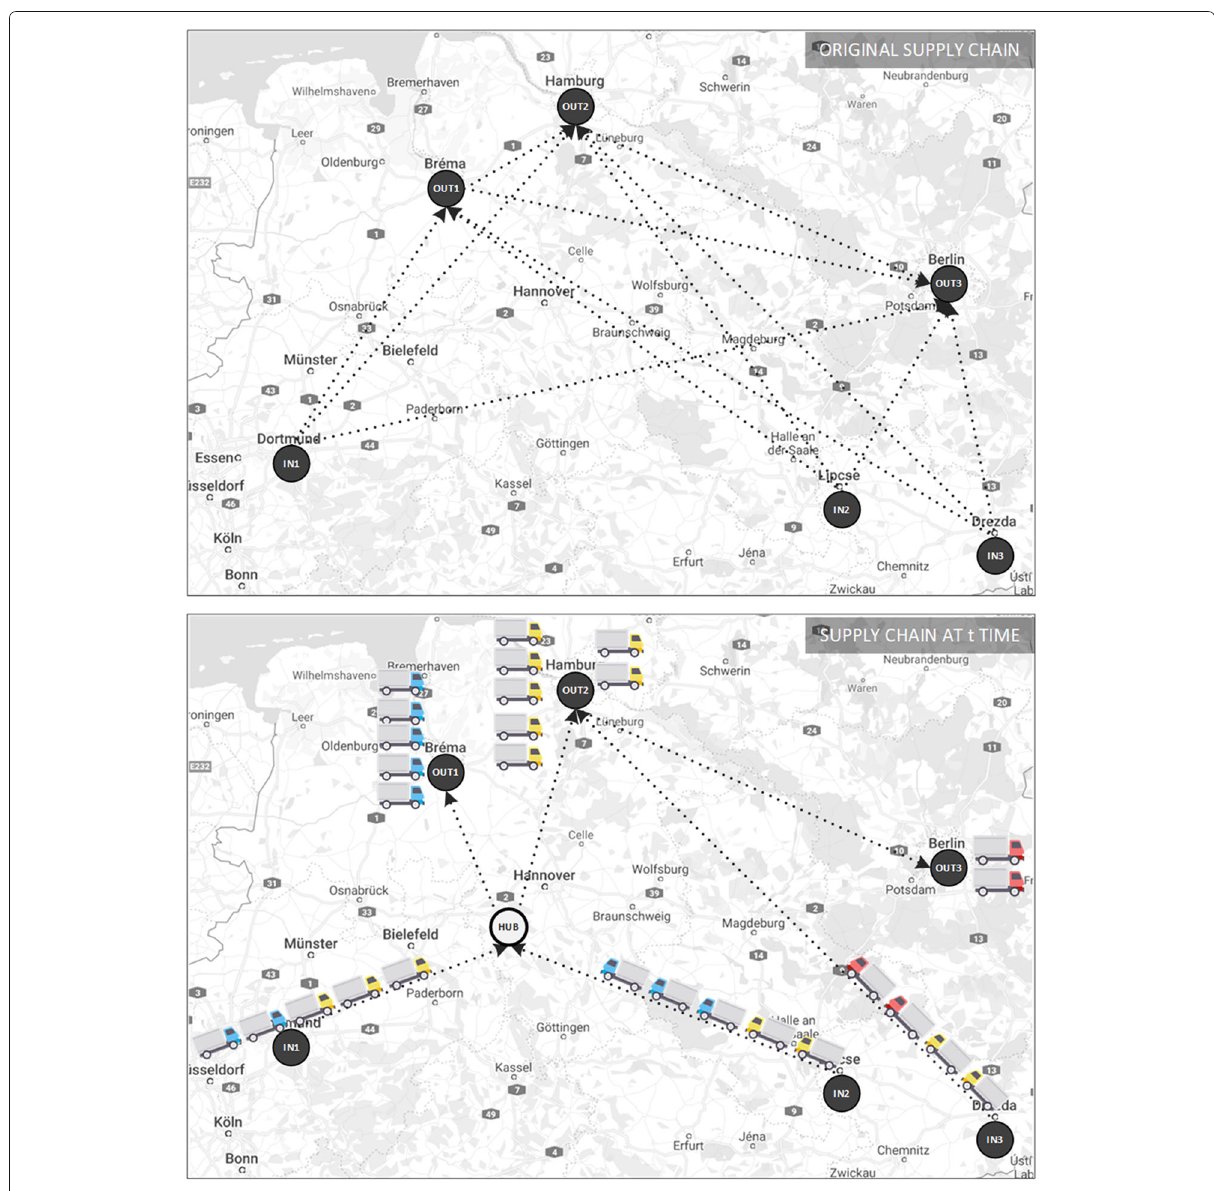
Fig. 5 The structure of the example network